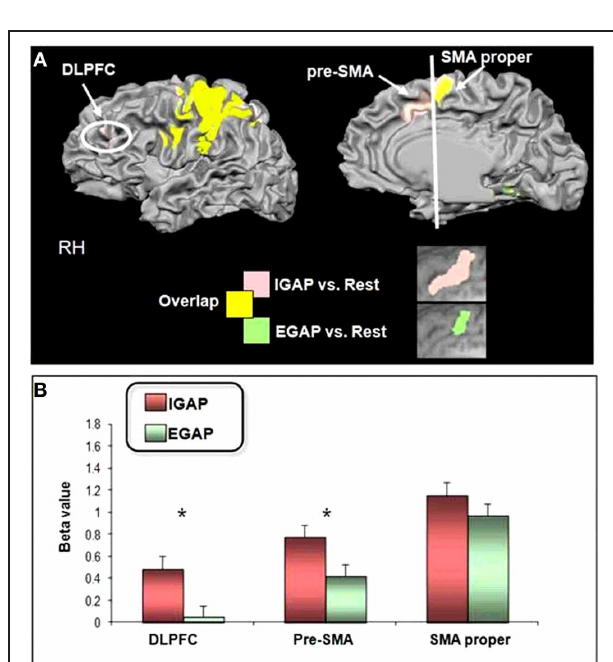
FIGURE 4 | Effects of source of action planning on fMRI activations. (A) 3D overlay of group activation map ( N = 14) onto a standardized T1-weighted MRI. (IGAP vs. rest in pink, EGAP vs. rest in green). (B) Estimated effect of source of planning as indicated by regional beta weights. The pre-SMA and the dorsolateral PFC (DLPFC) showed greater activation for the internally compared to externally guided conditions. *Indicates statistically significant difference at p < 0 . 005.